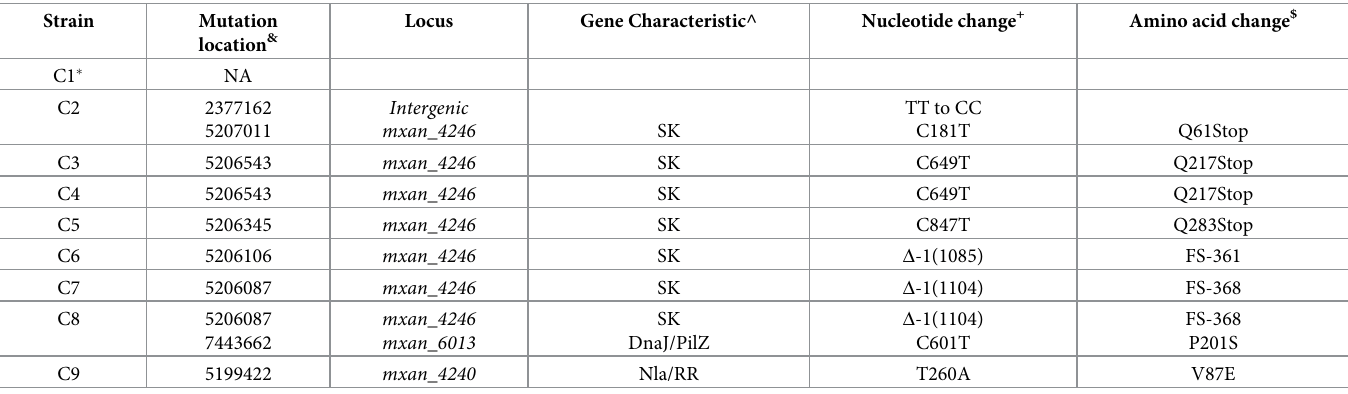
Table 1. M . xanthus Δ pilR suppressor